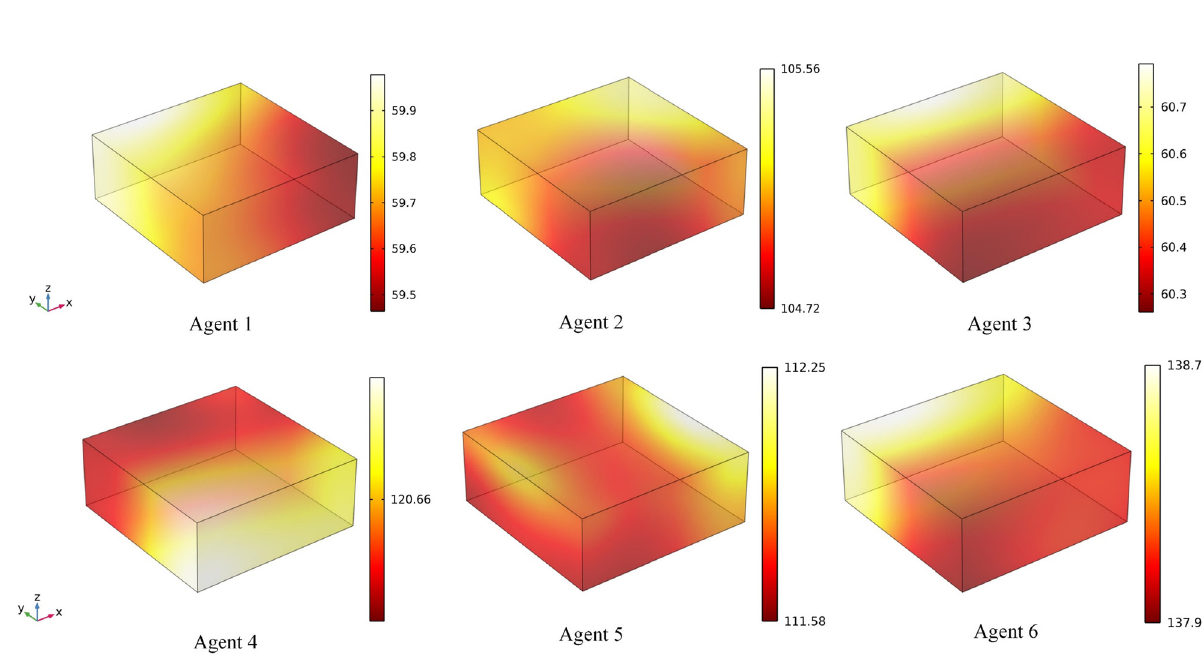
Figure 5: Comparison of the heating e ff ects of each microwave source agent